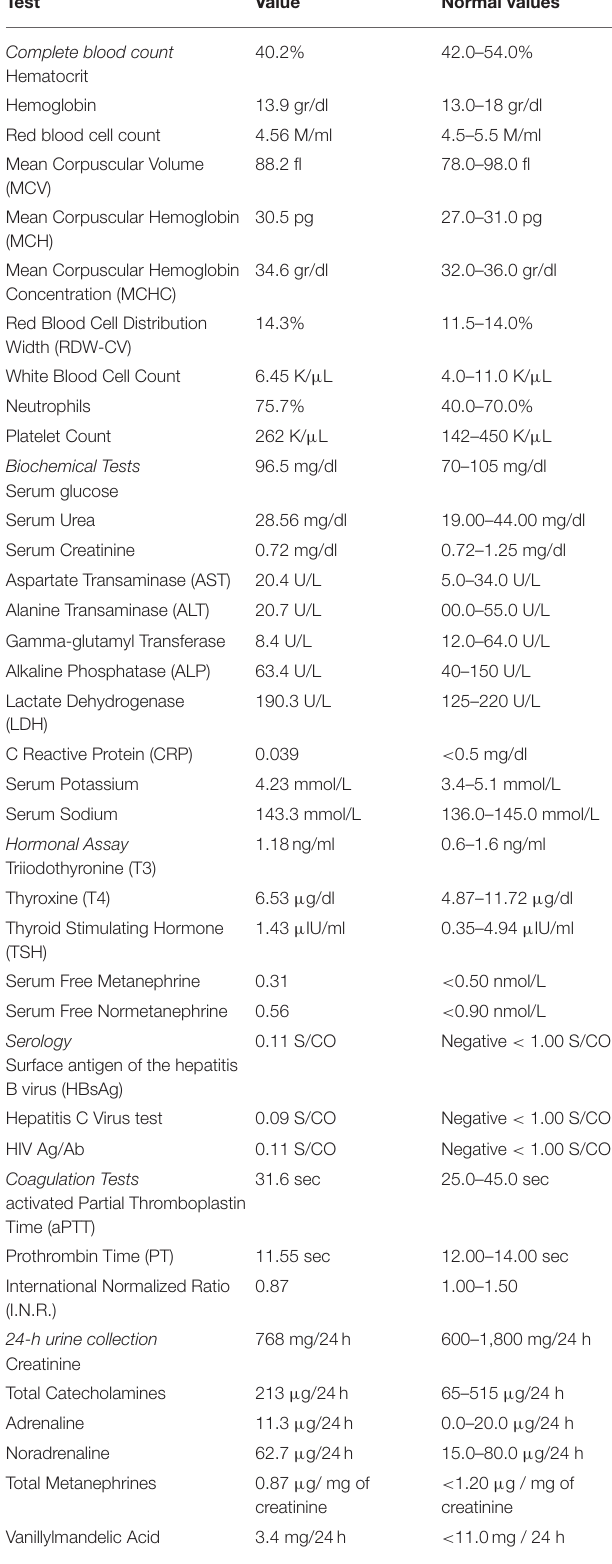
TABLE 1 | Patient’s laboratory